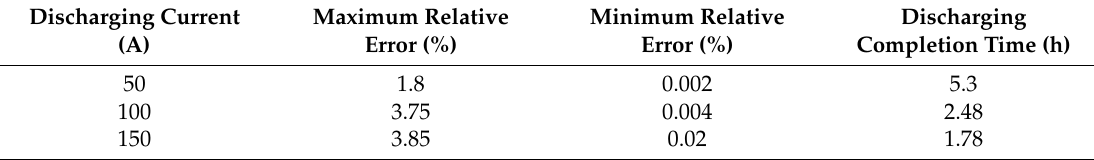
Table 5. Voltage error analysis of stack under different discharging currents.